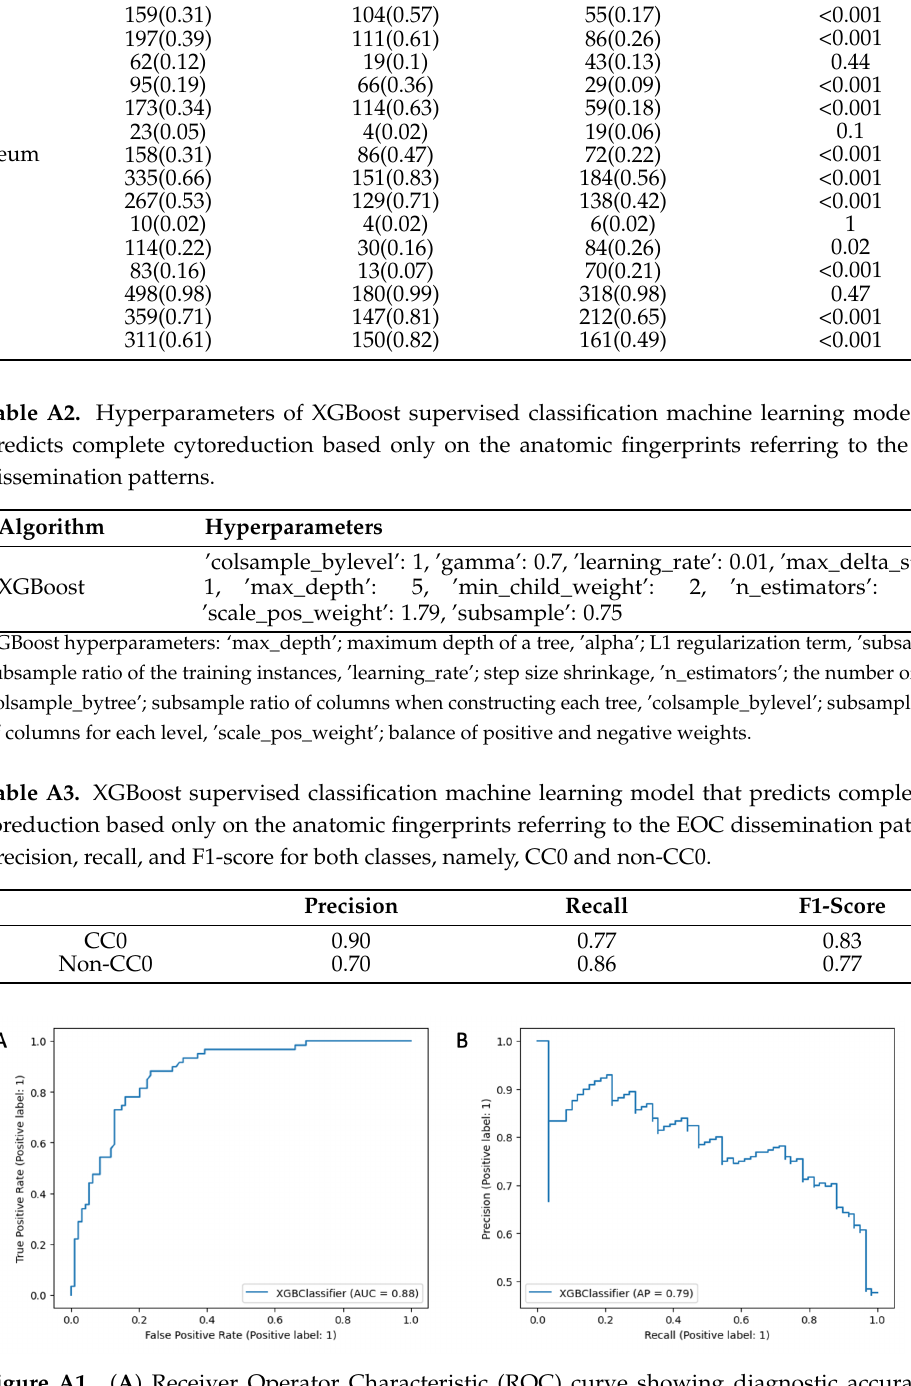
Figure A1. ( A ) Receiver Operator Characteristic (ROC) curve showing diagnostic accuracy of anatomic fingerprints referring to the EOC dissemination patterns for CC0 prediction (AUC = 0.88) ( B ) Precision Recall curve and Average Precision performance value (AP = 0.79). EOC; epithelial ovarian